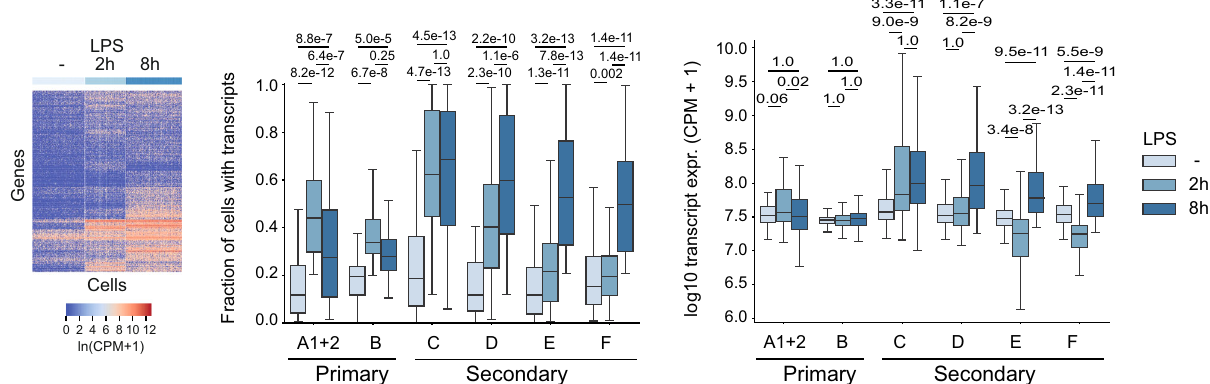
Fig. 2 Inducible gene transcription is driven primarily by the fraction of expressing cells. Left: heatmap of transcript levels (CPM) of inducible macrophage primary and secondary response genes 30 detected by scRNA-seq in at least 20% of cells. Centre: Fraction of cells with detectable transcripts for each of six previously de fi ned classes of inducible genes 30 at 0, 2 and 8 h after LPS activation. Right: Transcript levels (CPM + 1) per transcript-positive cell is shown for the same classes of inducible genes at 0, 2 and 8 h after LPS activation. Numbers represent adjusted P values for 0 versus 2 h and 0 versus 8 h. Two-sided Wilcoxon signed-rank test with Bonferroni correction for multiple testing. N = 682